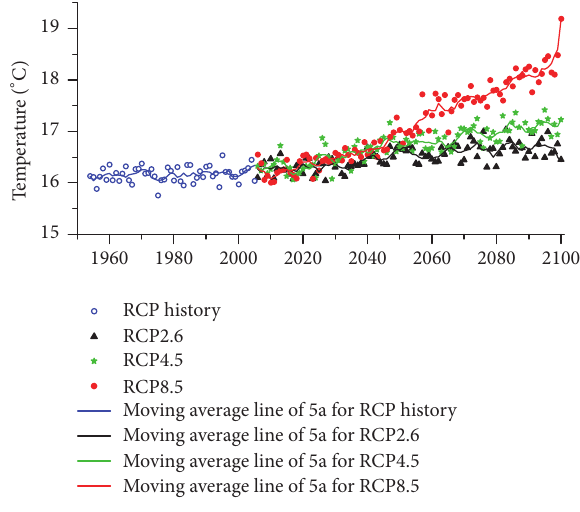
RCP8.5 Moving average line of 5a for RCP history Moving average line of 5a for RCP2.6 Moving average line of 5a for RCP4.5 Moving average line of 5a for Figure 6: Annual mean temperature series in Yunnan province under three